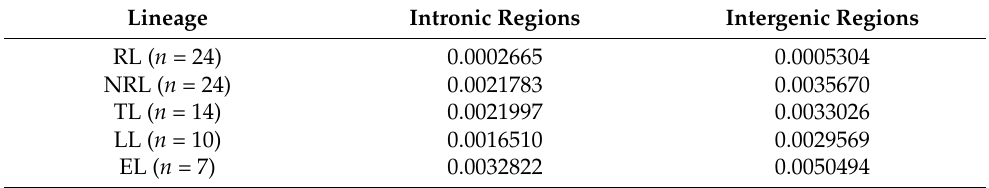
Table 1. Diversity in intronic regions and intergenic regions among different